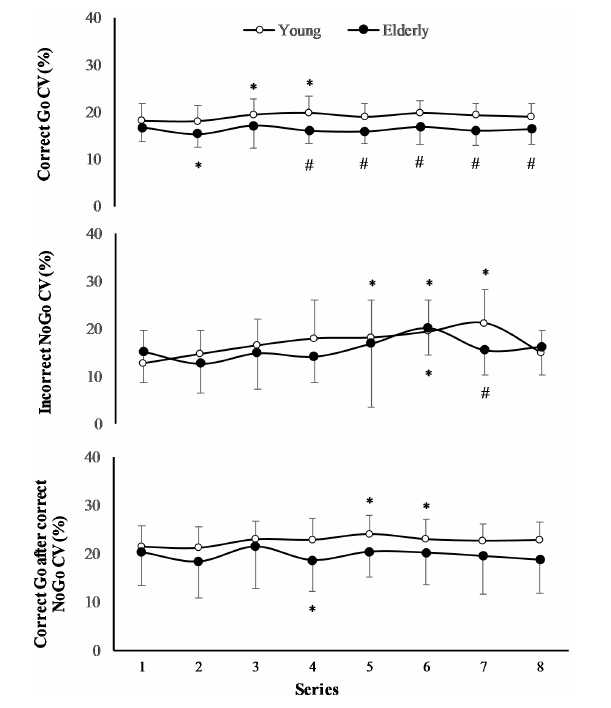
FIGURE 4 | Coefficient of variation (CV) of RT during 2 h “Go/NoGo” task. ∗ p < 0.05 compared with the first series; #p < 0.05 compared with the young men.